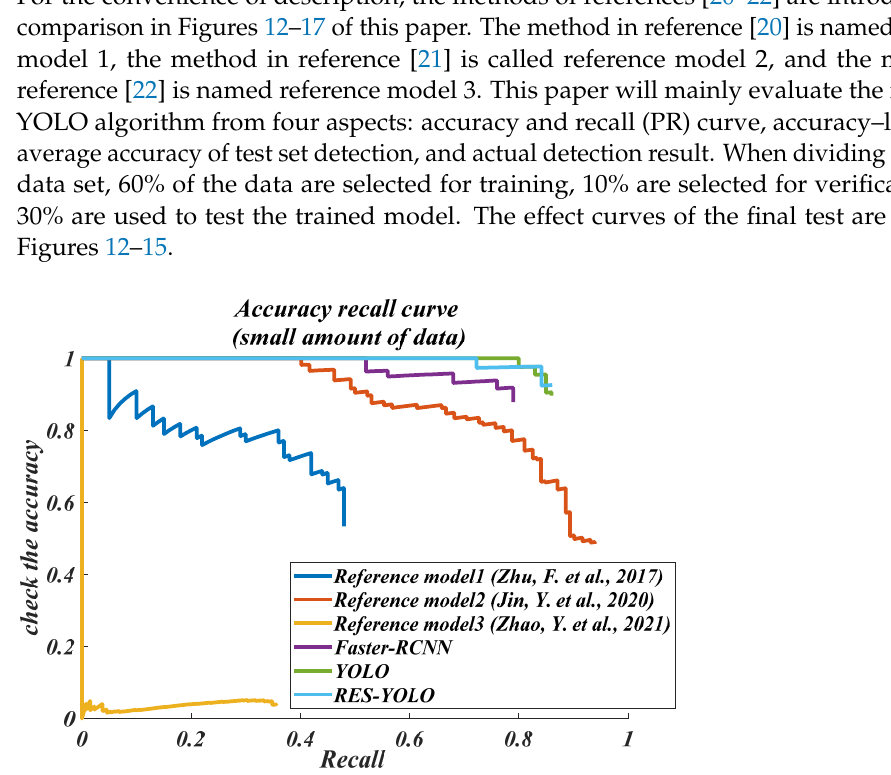
Figure 12. Precision and recall (PR) curve in small data set (small amount of data) [20–22].